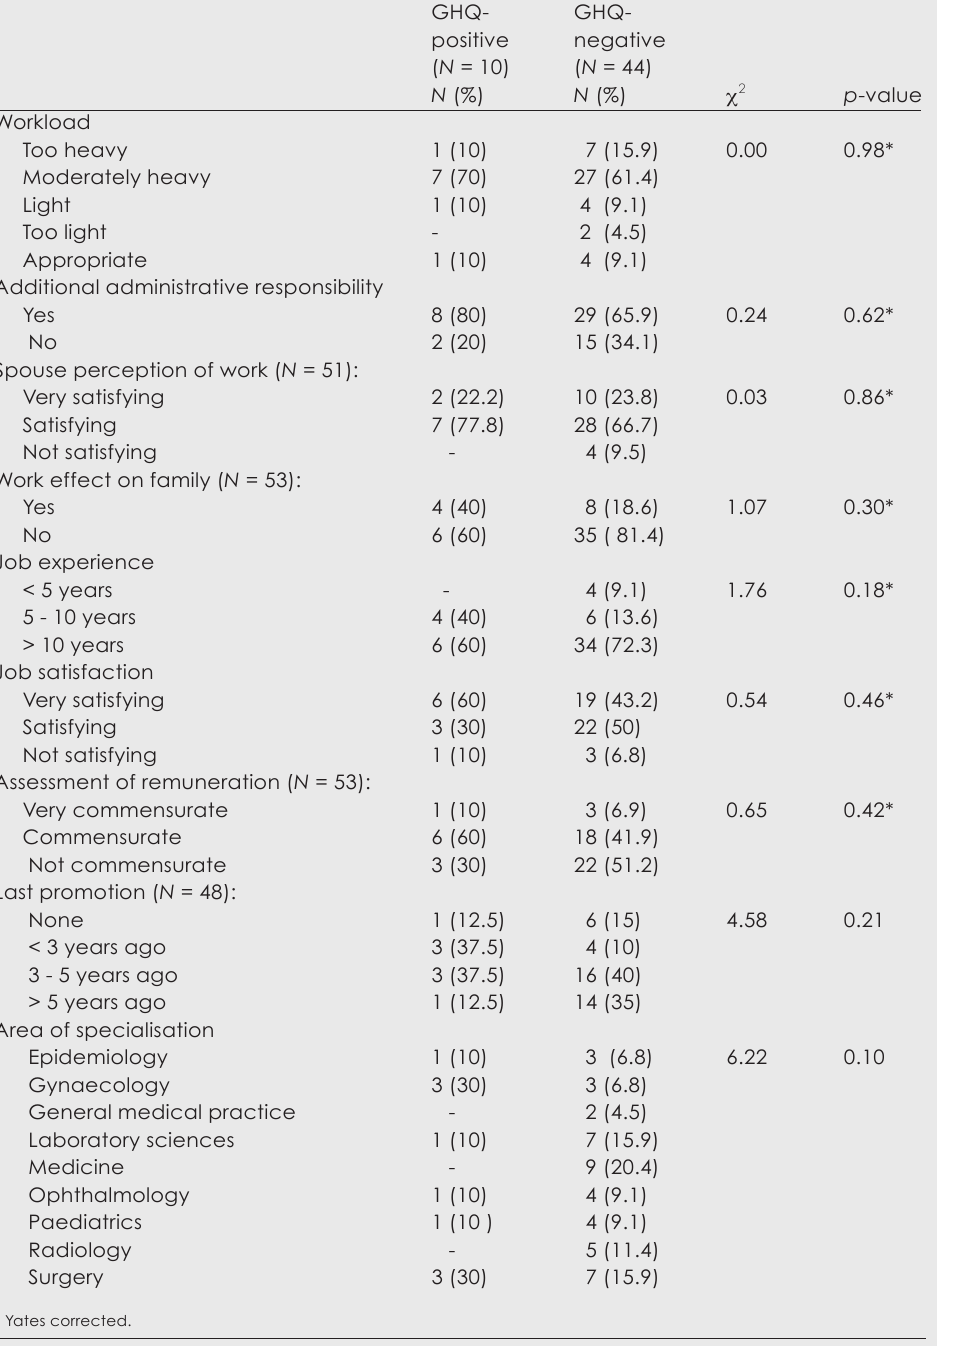
Table IV. Work-related factors among GHQ-positive and GHQ-negative